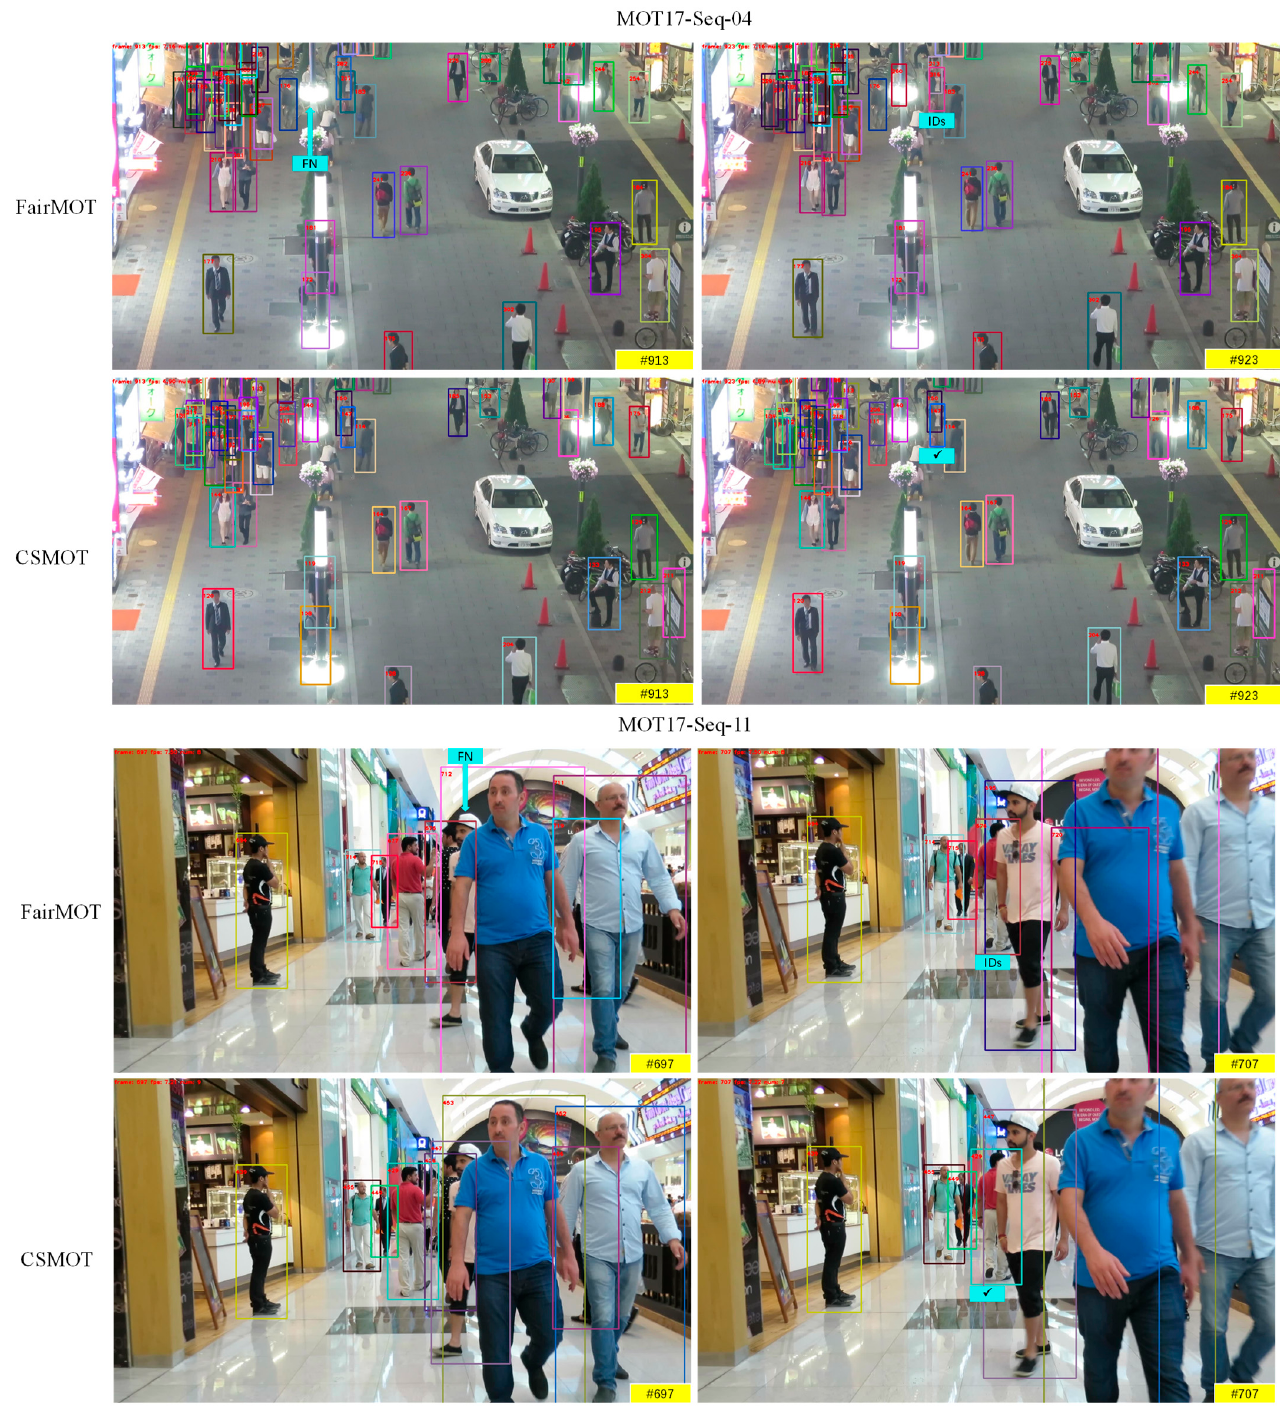
Figure 5. Robustness of our CSMOT compared to FairMOT. IDs and FN, respectively, indicate that the identity of the tracked object is switched and the object is not recognized. The checkmark indicates that the identity of the object is not switched.